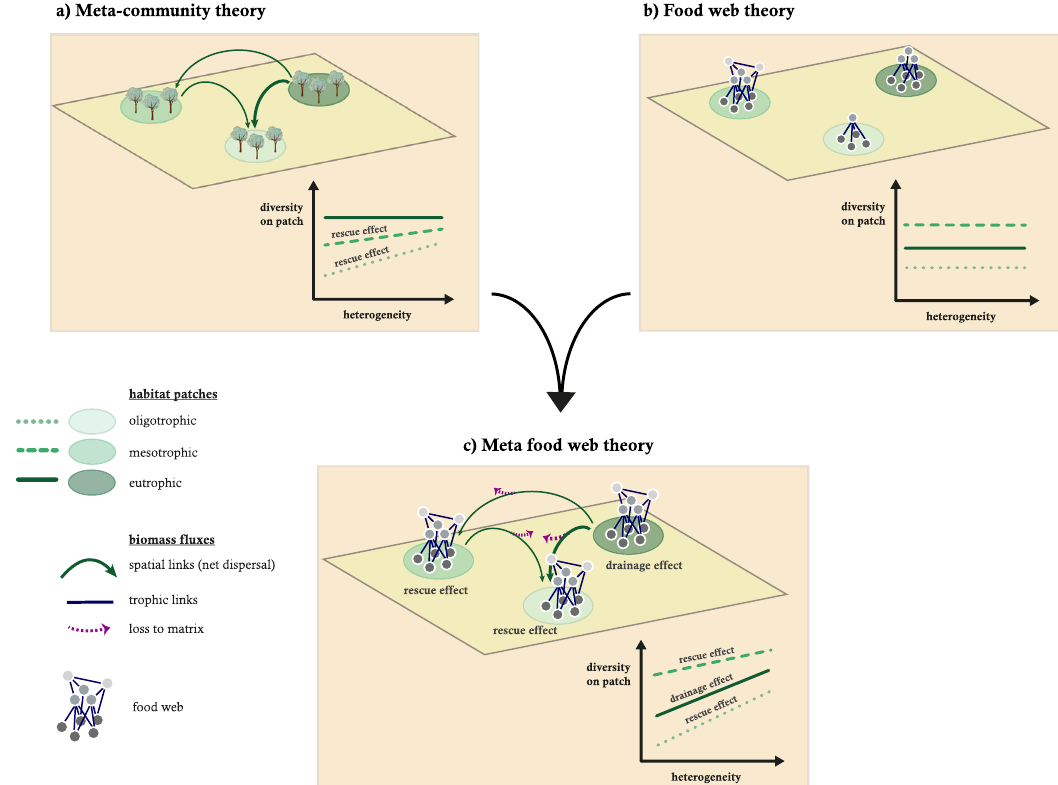
Fig. 1 Conceptual fi gure illustrating the synthesis of metacommunity theory and food-web theory into meta-food-web theory. Panel a illustrates metacommunity dynamics with net dispersal from larger (nutrient richer patches; darker green) to smaller populations (nutrient poorer patches; lighter green) and the associated rescue effect on local diversity. Panel b illustrates local food-web dynamics on patches with different nutrient richness (shades of green) and the effect of the paradox of enrichment on local diversity. Panel c illustrates the synthesis of metacommunity and food-web dynamics and the interaction of rescue and drainage effects and their consequence for biodiversity. Heterogeneity arises as patches with different nutrient supplies occur, which yields a rescue effects on oligotrophic and mesotrophic patches in metacommunities, b patterns with the highest biodiversity on mesotrophic patches in food webs, and c rescue (oligotrophic patches) and drainage effects (eutrophic patches) in